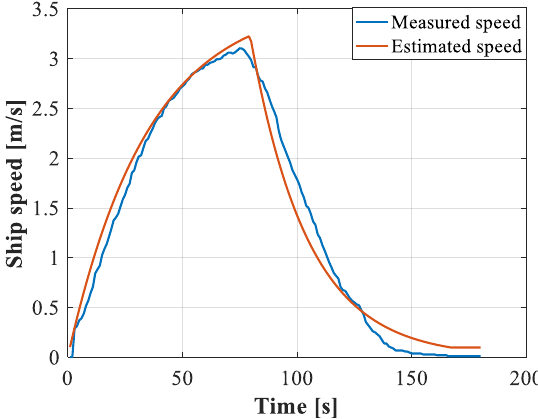
Figure 3 - Measured and estimated curves of the ferry speed. Figure 3. Measured and estimated curves of the ferry